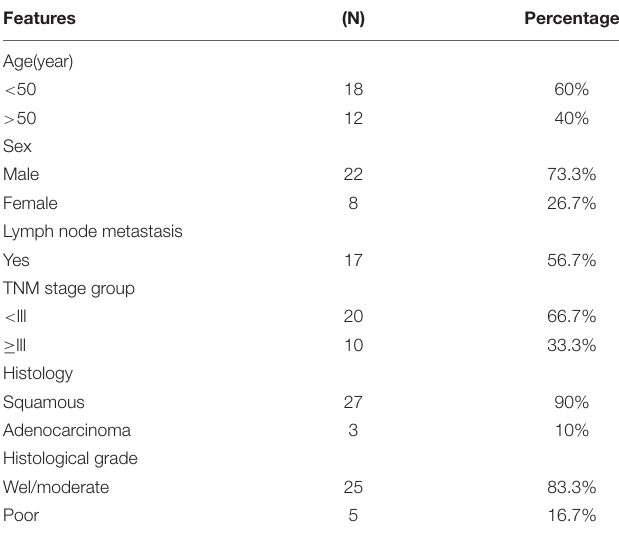
TABLE 1 | Clinical Features of LC